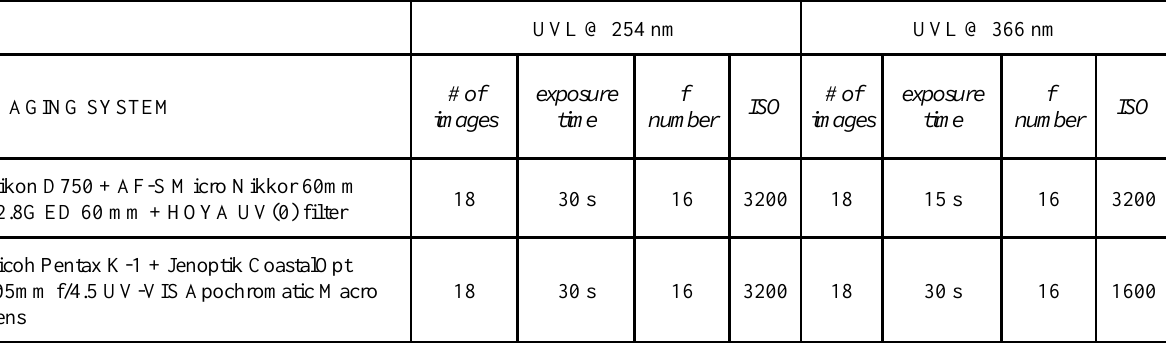
Table 2. Camera settings for the UVL imaging